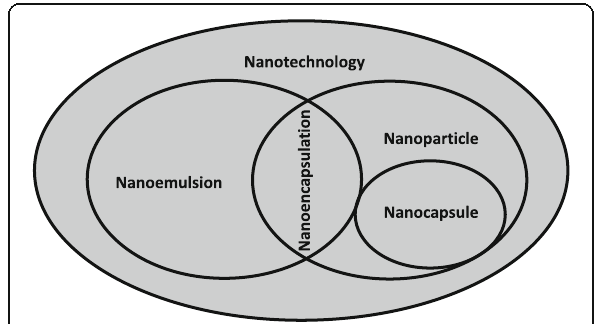
Fig. 2 Scheme of the nanoencapsulation definitions commonly used for